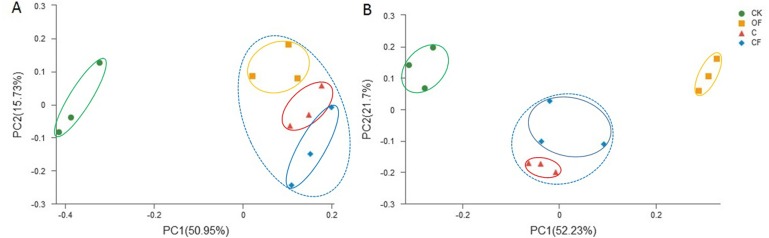
Principal coordinate analysis (PCoA) of (A) bacterial and (B) fungal community in the four soils studied at the OTU level based on 97% similarity.